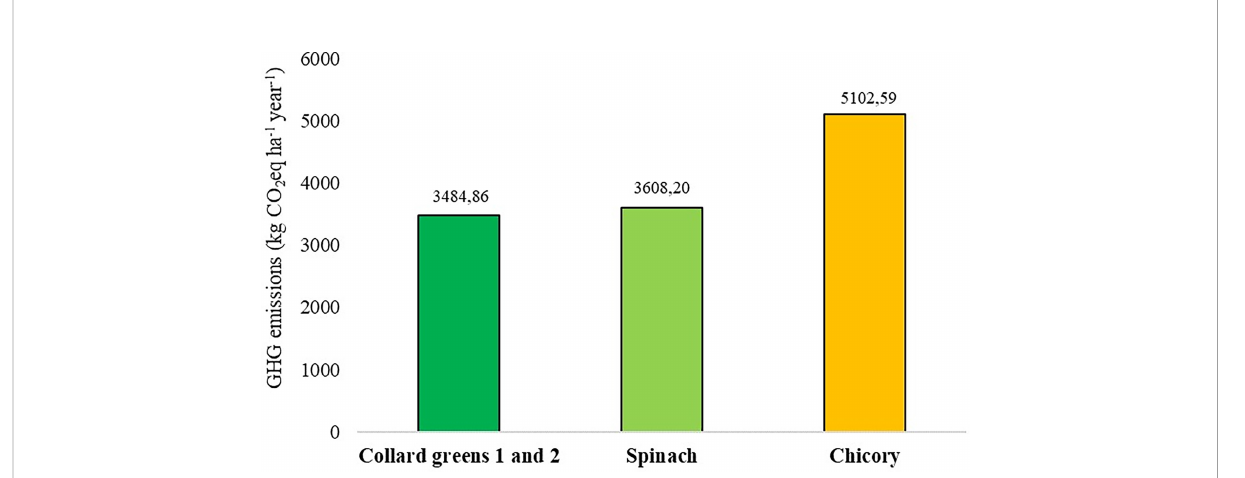
FIGURE 3 Total GHG emissions (kg CO 2 eq ha -1 year -1 ) for individual production of each species in monoculture scenarios: MCS – monocultures of collard greens 1 and New Zealand spinach and MCC – monocultures of collard greens 2 and